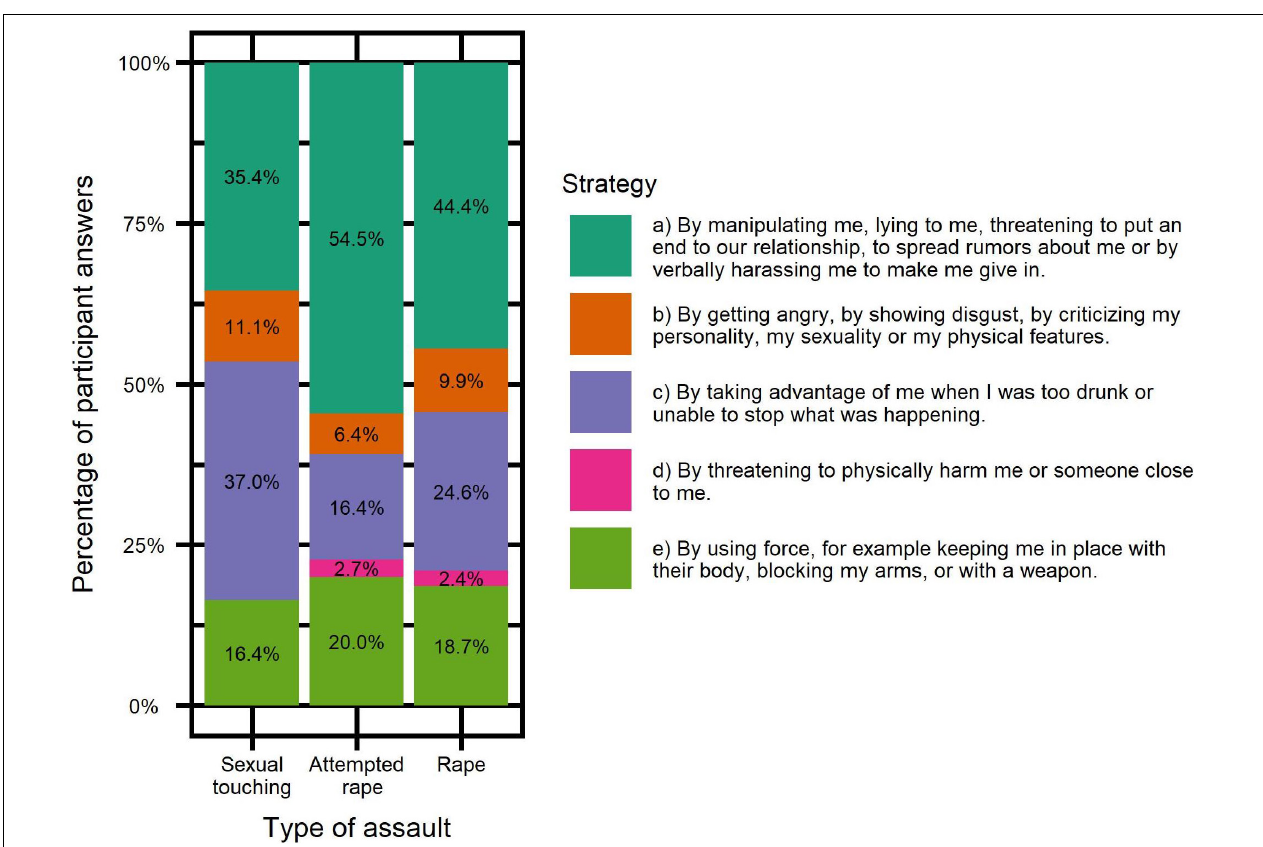
FIGURE 3 | Strategies used depending on the type of